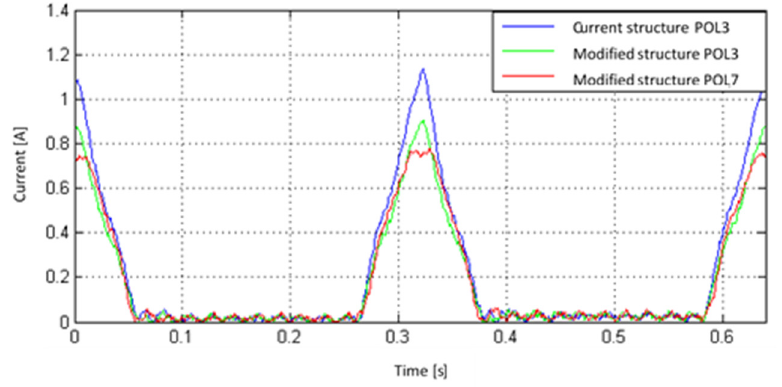
Figure 17. Course of current in drive M1, during reverse motion, in all designs at a velocity of 160 min − 1 .